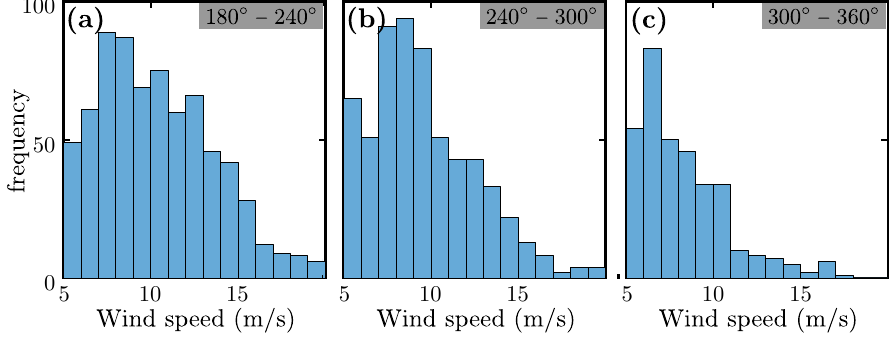
Figure 10. Hourly average wind speed values during the period March 2009–March 2010 according their wind direction, for wind speeds larger than the observed wind speed threshold. ( a ) 180 ◦ –240 ◦ , ( b ) 240 ◦ –300 ◦ and ( c ) 300 ◦ –360 ◦